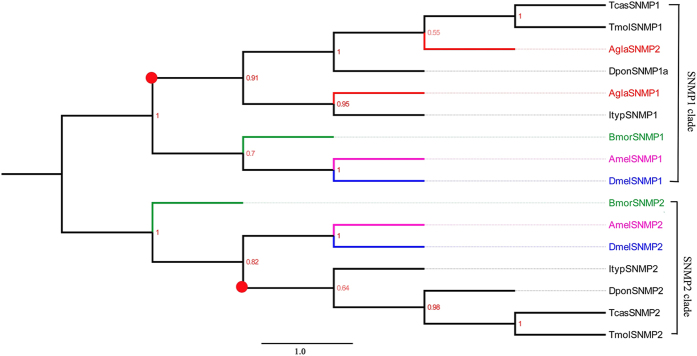
Neighbor-joining tree of candidate sensory neuron membrane proteins (SNMPs).The NJ phylogenetic analysis of SNMPs of A. glabripennis (AglaSNMP, red) was performed with reference SNMPs of D. ponderosae (DponSNMP, dark), I. typographus (ItypSNMP, dark), T. molitor (TmolSNMP, dark), T. castaneum (TcasSNMP, dark), D. melanogaster (DmelSNMP, Diptera, blue), Bombyx mori (BmorSNMP, Lepidoptera, green), and Apis mellifera (AmelSNMP, Hymenoptera, purple). The stability of the nodes was assessed by bootstrap analysis with 1,000 replications, and only bootstrap values ≥0.6 are shown at the corresponding nodes. The scale bar represents 1.0 substitution per site.